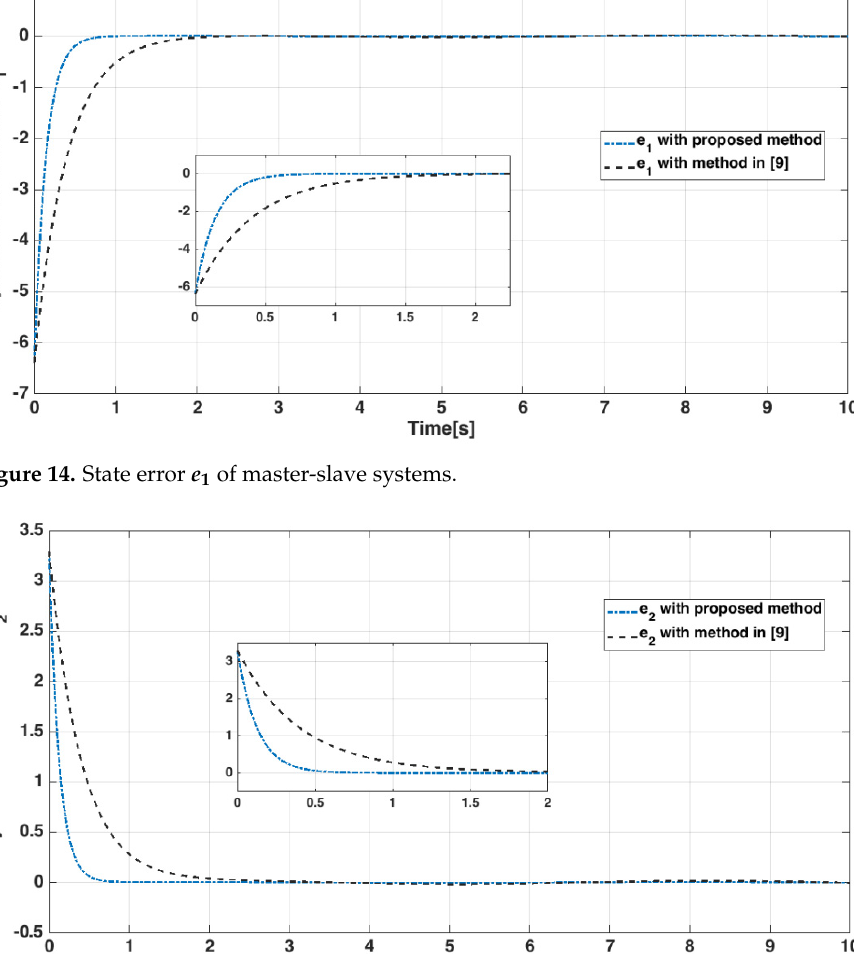
Figure 13. States 𝒙 𝟔 and 𝒚 𝟔